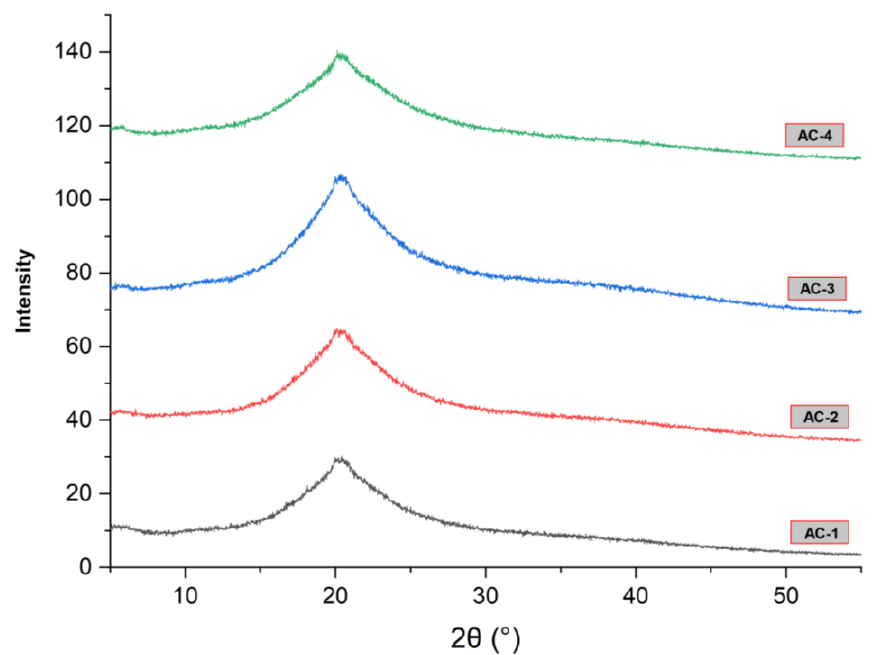
Figure 3. X-ray diffraction pattern of SA–AG hydrogel-based edible films; AC-1/blank, AC-2 con- tained 15 μL of CEO, AC-3 contained 20 μL of CEO, and AC-4 contained 30 μL of CEO.